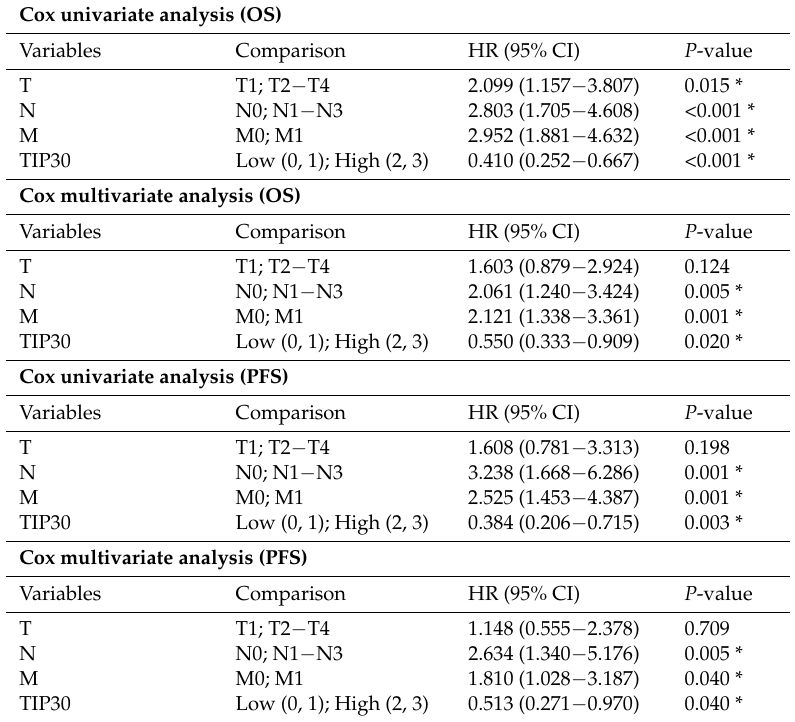
Table 4. Cox univariate and multivariate regression analysis of prognostic factors for overall and progression-free survival in 113 NSCLC